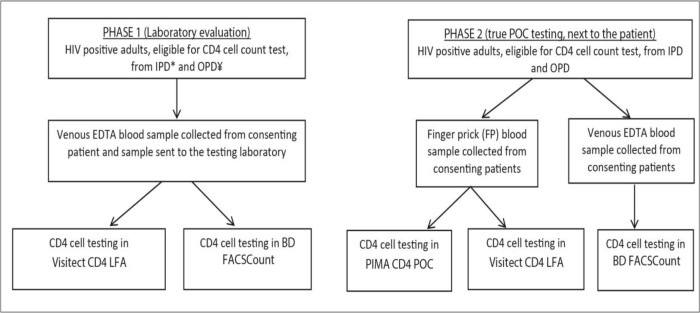
Study sample collection and testing flow.Key: *IPD-in-patient department, ¥OPD-out patient department.